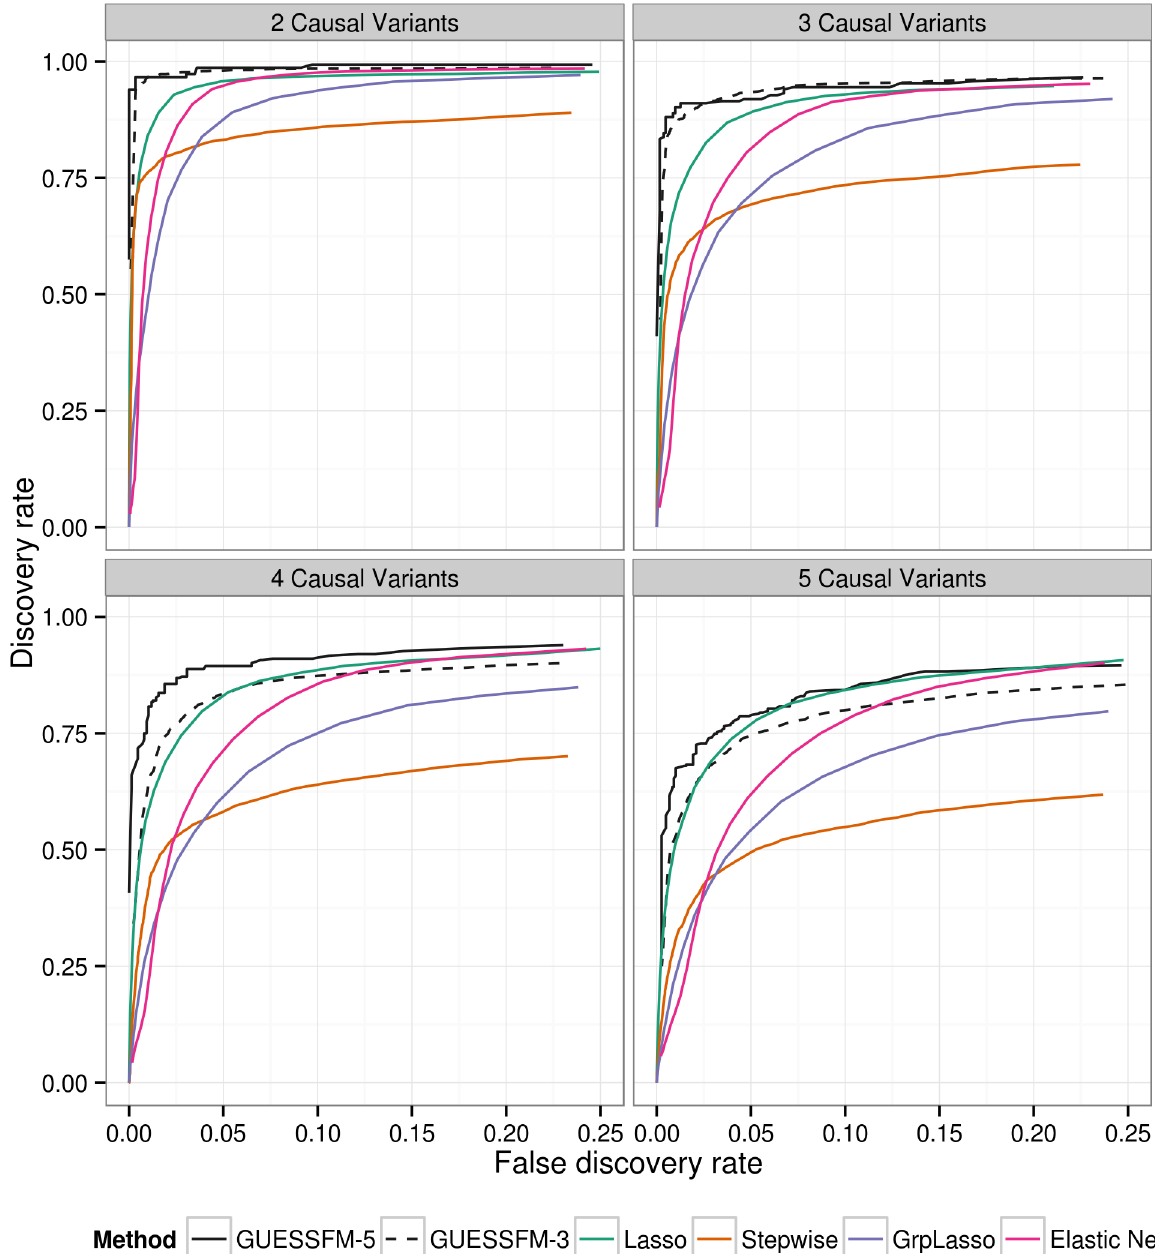
Fig 2. Comparison of of several multivariate methods for fine mapping using simulated data. We simulated quantitative phenotype data with between two and five causal variants using genotype data from the T1D dataset for the IL2RA region. The simulated data sets were analysed using forward stepwise regression, GUESSFM, the lasso, the group lasso and the elastic net. GUESSFM produces credible sets for each variant chosen using the snp.picker algorithm described in Materials and Methods. We defined pseudo “ credible sets ” for the other approaches as the set of SNPs with r 2 > 0.8 with a selected SNP. We calculated the discovery rate (the proportion of causal variants within at least one credible set, y axis) and false discovery rate (proportion of detected variants whose credible sets did not contain any causal variant, x axis) at different thresholds for the stepwise p value, the group marginal posterior probability of inclusion (gMPPI) for GUESSFM and the regularization parameter(s) across simulated datasets (see Methods for details). GUESSFM-3 and GUESSFM-5 refer to GUESSFM run with a prior expectation of three or five causal variants per region, respectively. Results are averaged over 1000